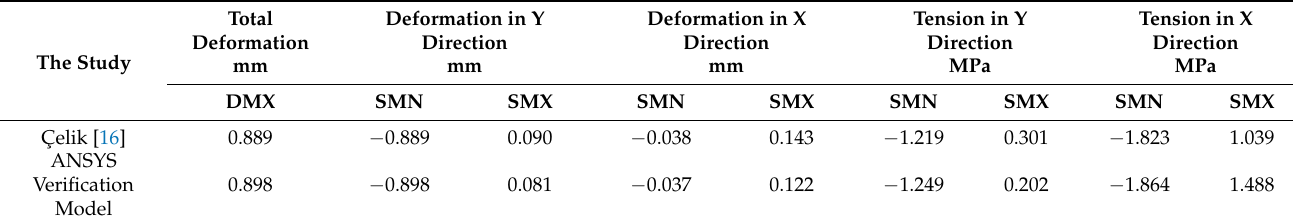
Table 1. Comparison of the wheel loads verification model.